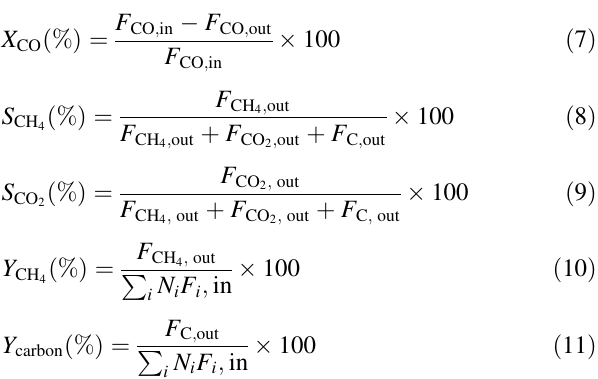
a CO conversion, b CH 4 selectivity, c CH 4 yield, and d